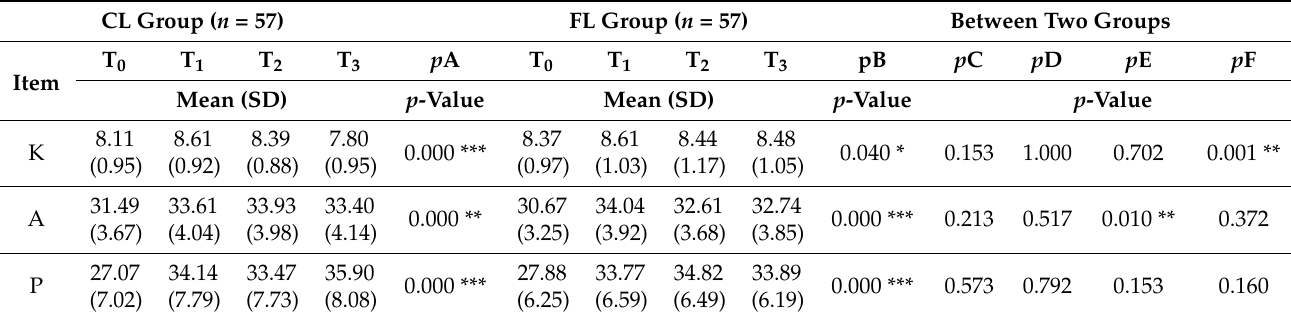
Table 2. Knowledge, attitude, and practice of EBP (N =